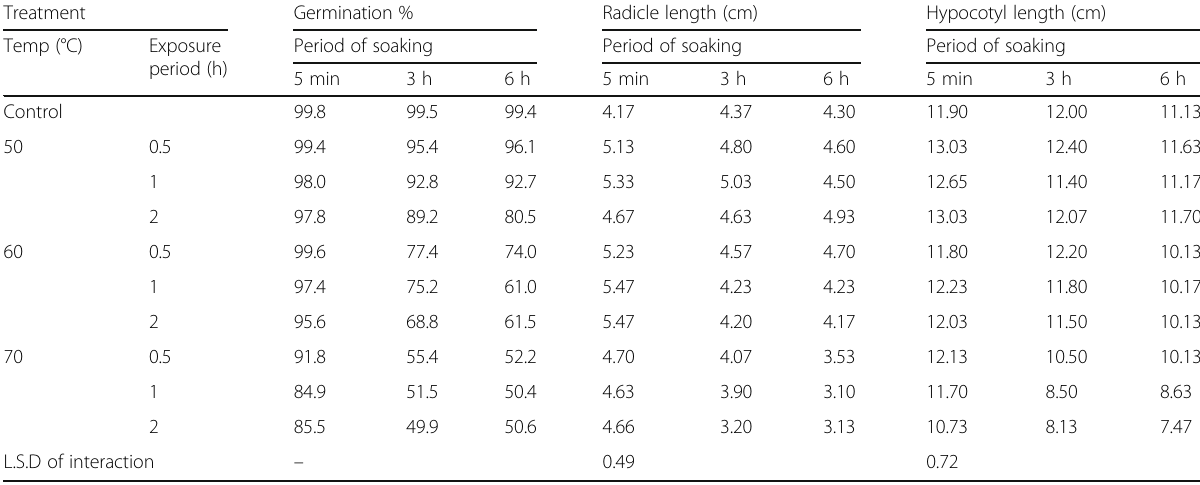
Table 2 Effect of seed hardening on germination percentage, radicle length (cm), and hypocotyl length (cm)